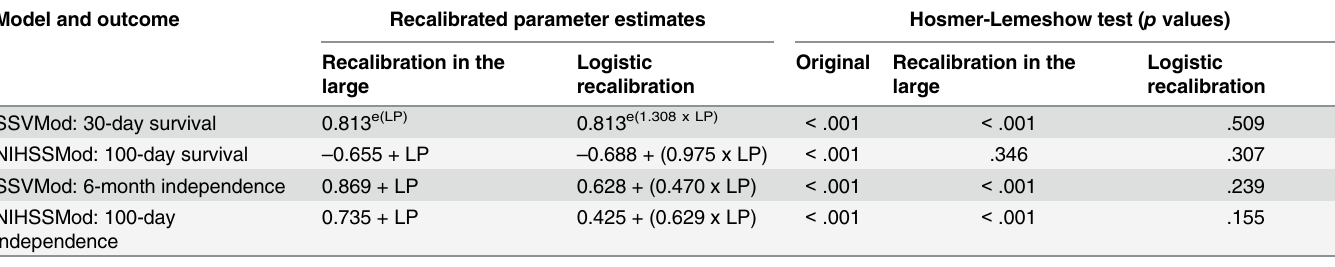
Table 8. Recalibration of the SSVMod and the